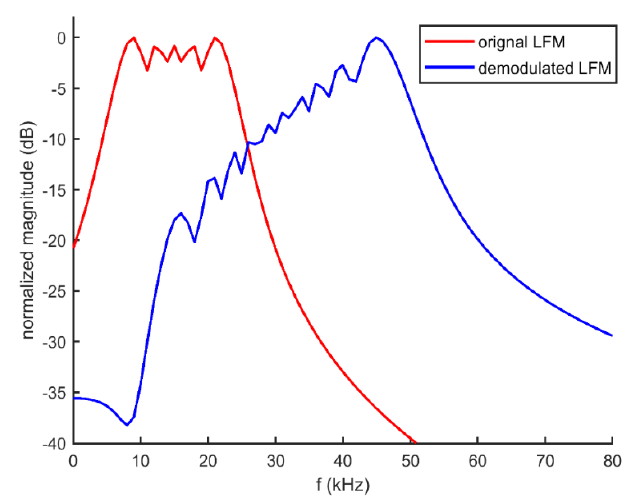
Figure 3. Comparison of the original LFM and self-demodulated LFM in frequency domain.